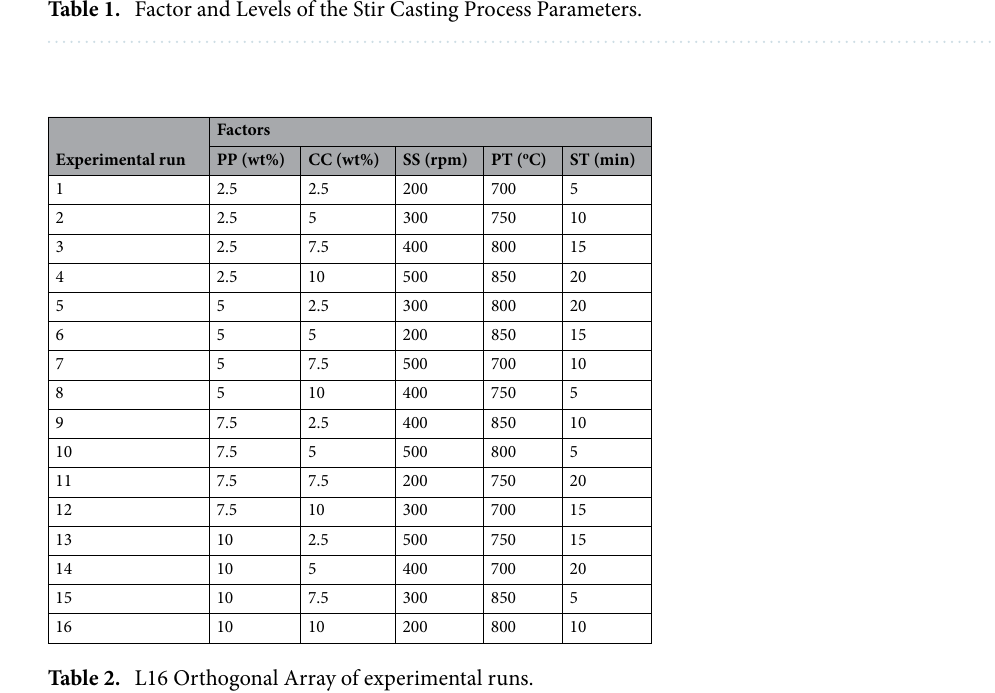
Table 2. L16 Orthogonal Array of experimental